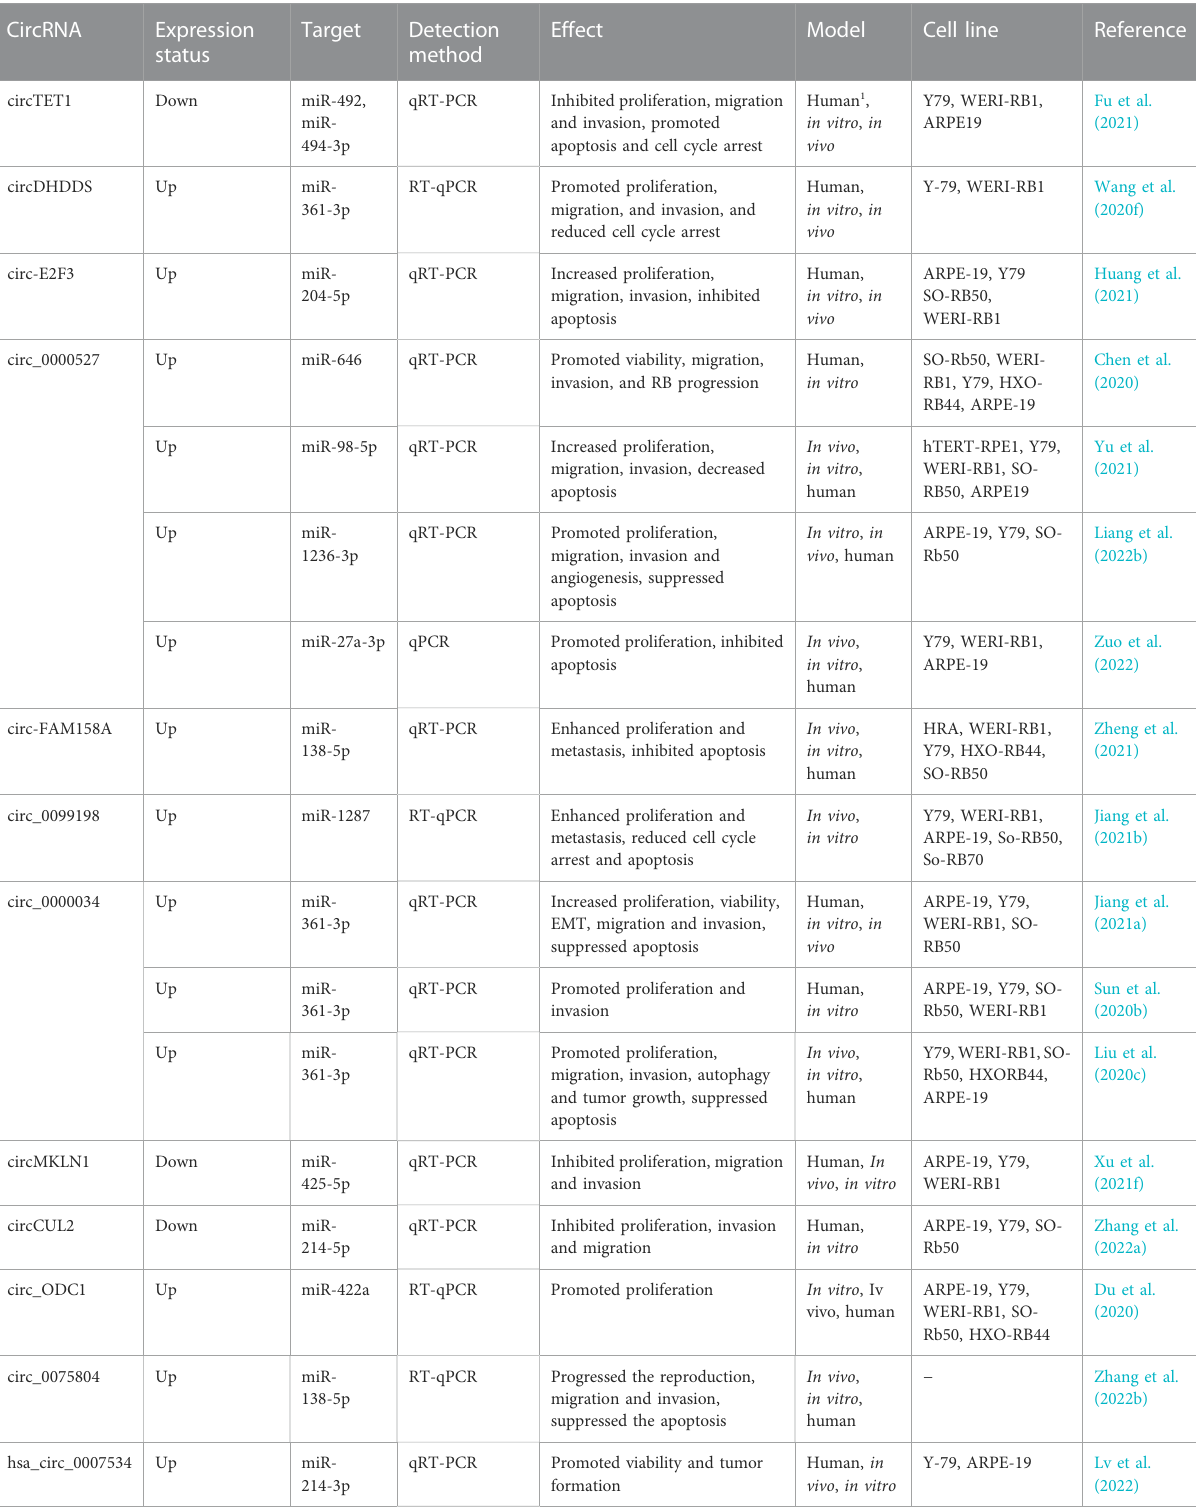
TABLE 3 The role of circRNAs in